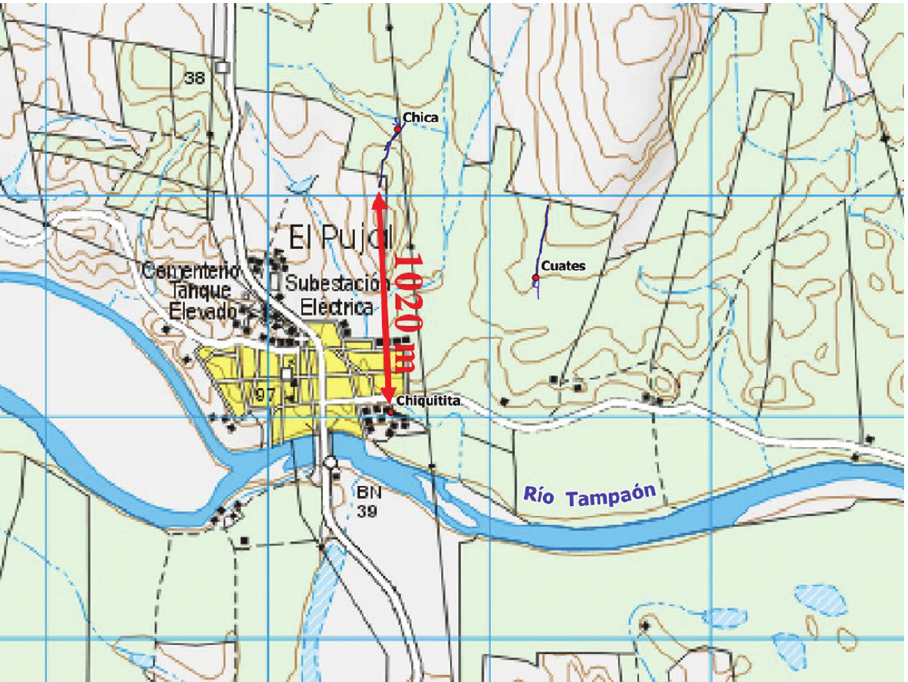
Figure 2. Topographic map of El Pujal area, in the southern-most Sierra de El Abra. Overlaid is the line topography of Chica, Cuates and Chiquitita